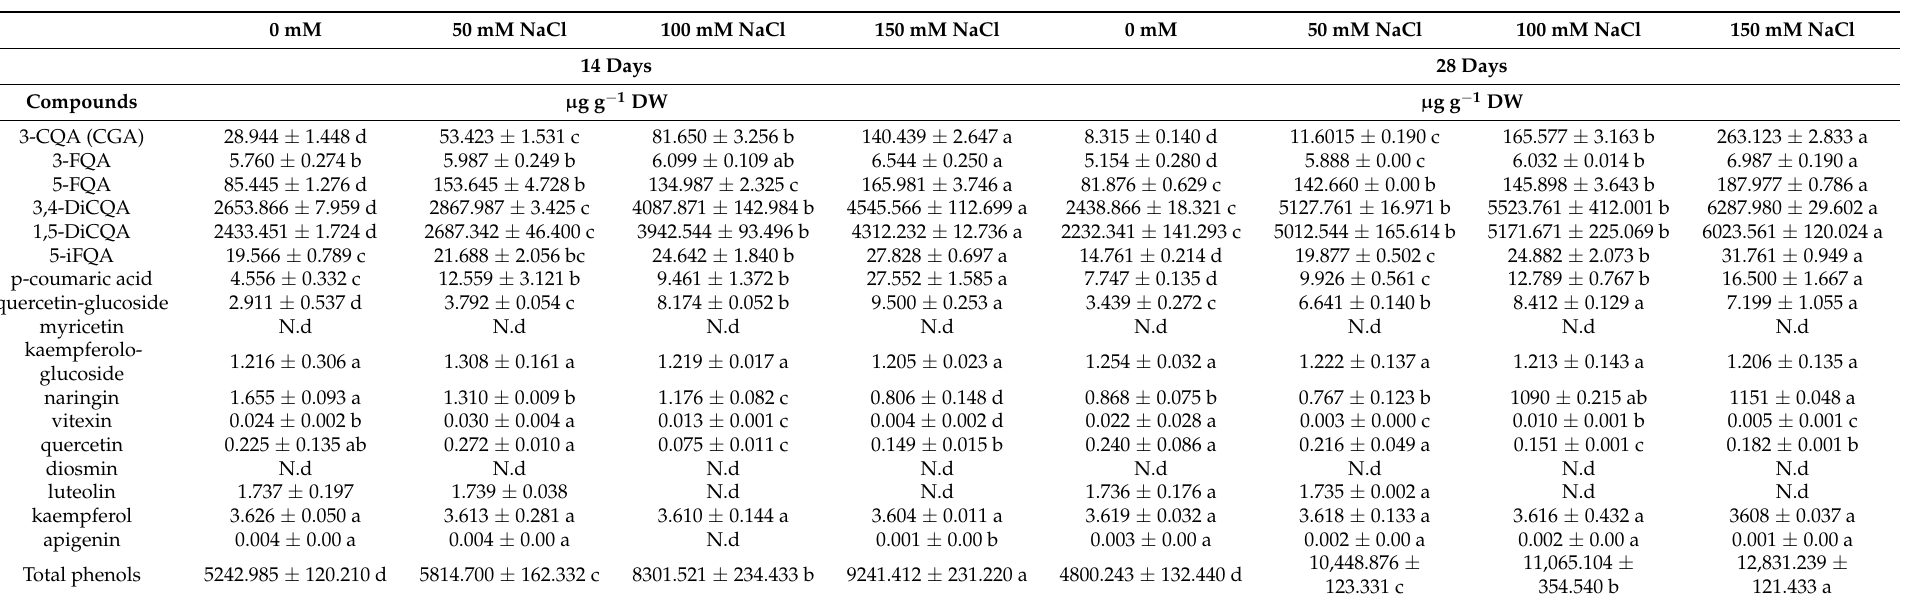
Table 2. Changes in polyphenol content measured by HPLC-MS analysis in cardoon callus cultures in response to NaCl treatment (0, 50, 100, or 150 mM) for 14 or 28 days. Each value represents the mean of three biological replicates ± SD. Statistical significance for each compound among treatments within each time point was determined by using one-way ANOVA with Tukey’s post hoc test. Different letters indicate significant difference ( p -value <